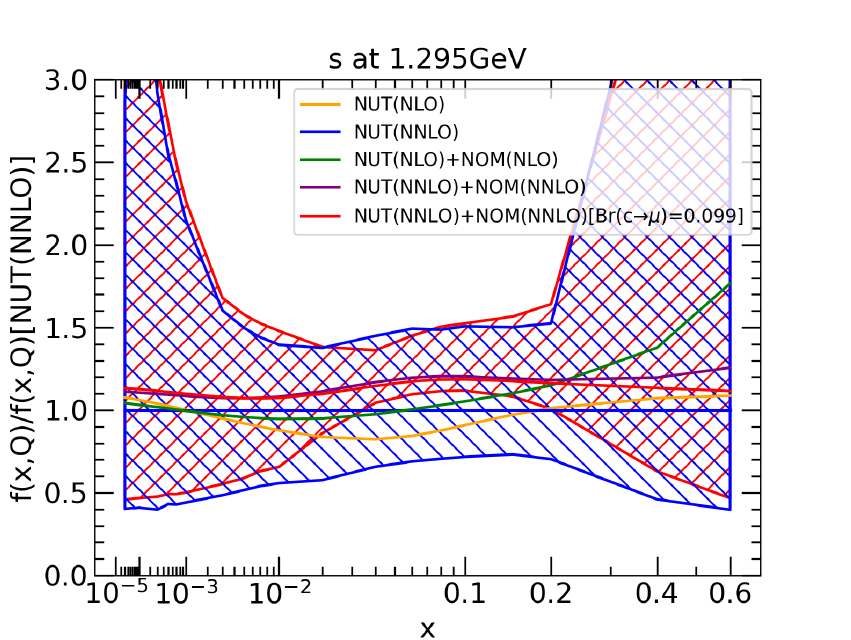
Figure 26 . Strange-quark PDF at Q = 1 . 295 GeV from LM scans in global fits with various conditions. The PDF uncertainties are shown for 68% CL.